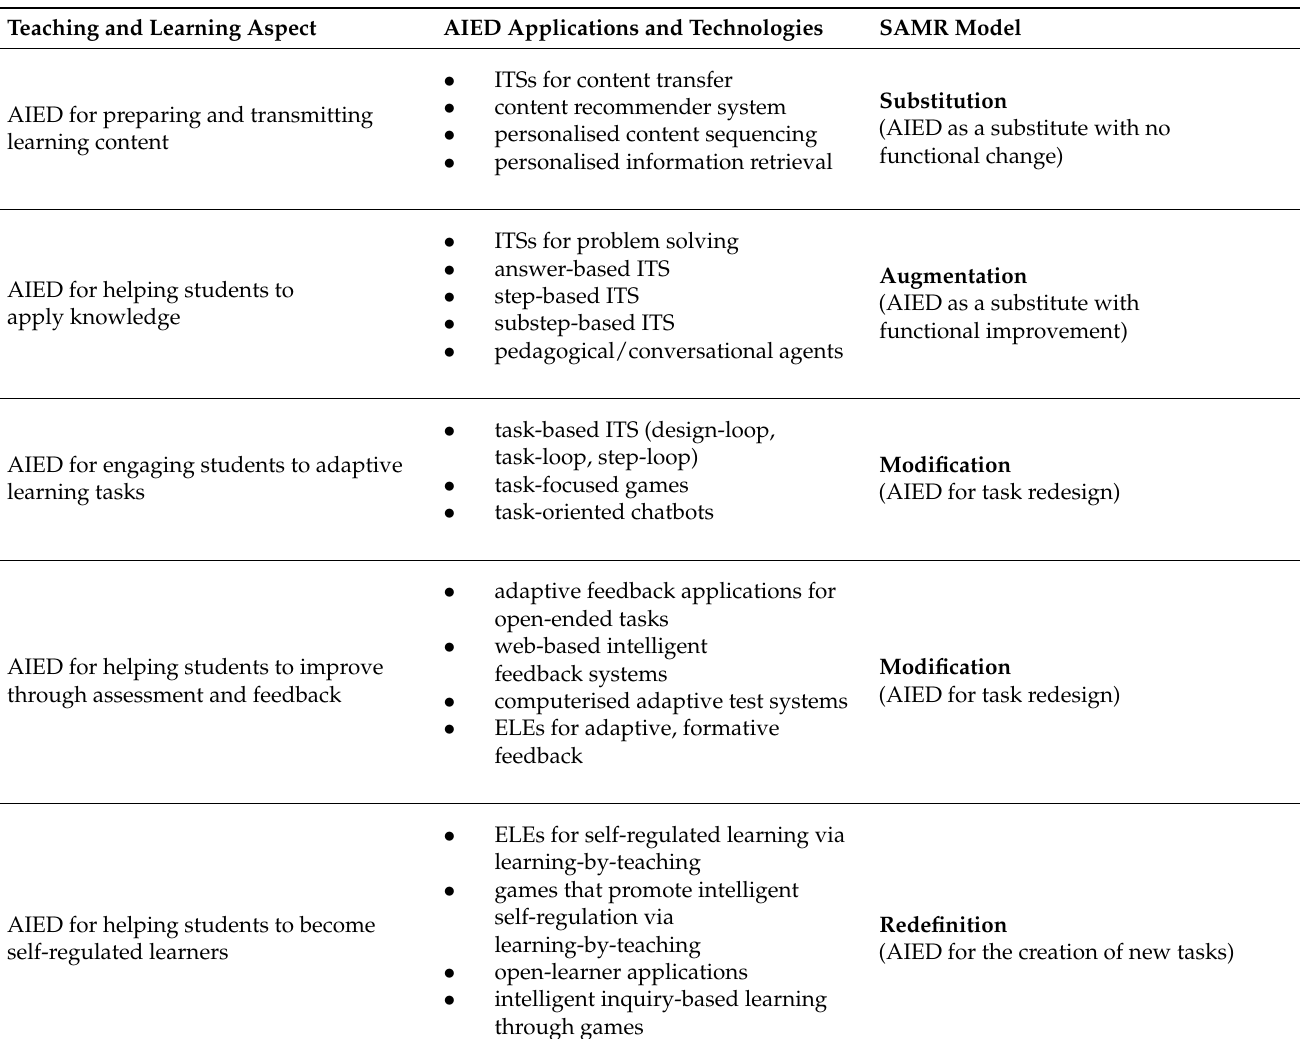
Table 5. Representation and mapping of teaching and learning aspects with AIED applications and SAMR